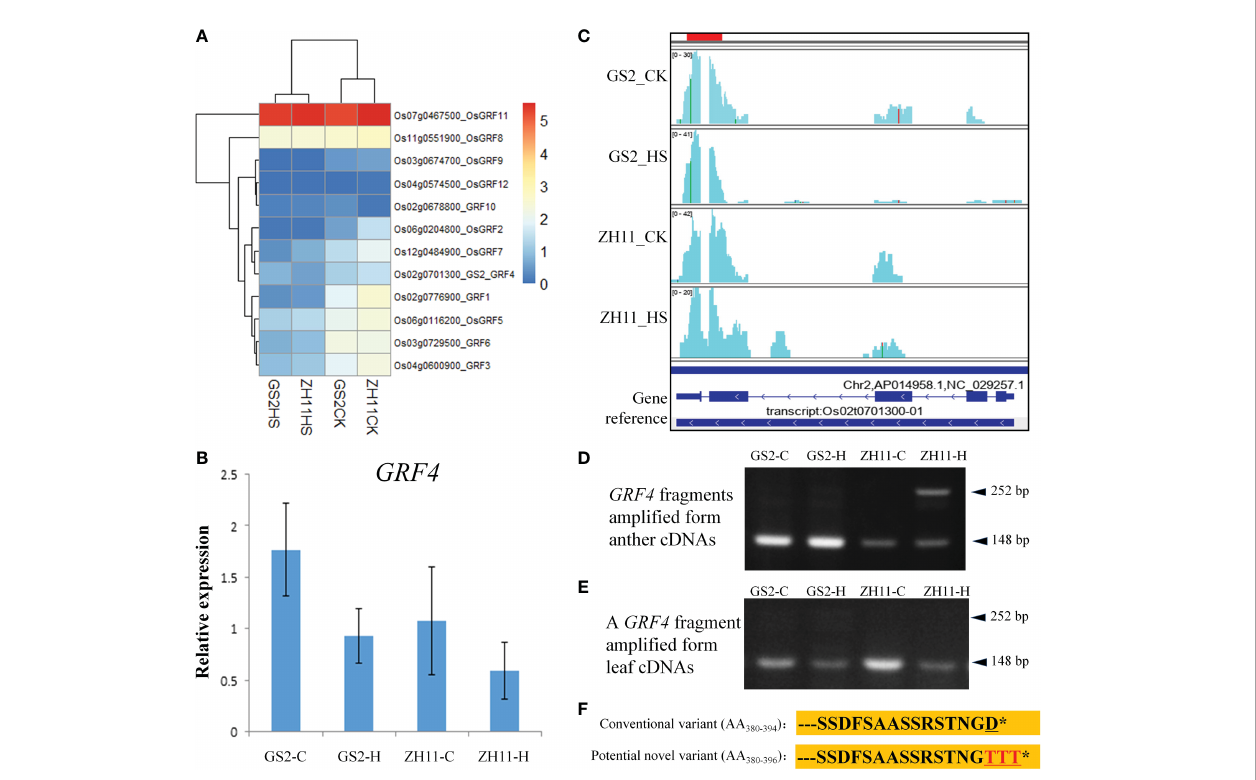
FIGURE 6 Expressions of growth regulation factors (GRFs) under different temperature conditions. (A) Expression patterns of GRFs in RNA sequencing (RNA-Seq) data. (B) Expression of OsGRF4 ( Oryza sativa growth-regulating factor 4) measured by reverse transcription-quantitative PCR (qRT-PCR). (C) Visualization of coverage of sequencing reads annotated to OsGRF4 gene using the IGV program. (D) Reverse transcription-PCR (RT-PCR) validation of the intron retention (IR) event detected in OsGRF4 . (E) RT-PCR ampli fi cation of OsGRF4 by using leaf cDNA as a template. (F) Amino acid residues of the conventional OsGRF4 protein and that of the potential protein variant translated from the intron-retained mRNA isoform. Only amino acid residues from position 380 on are shown. * stands for the terminal point of the amino acid